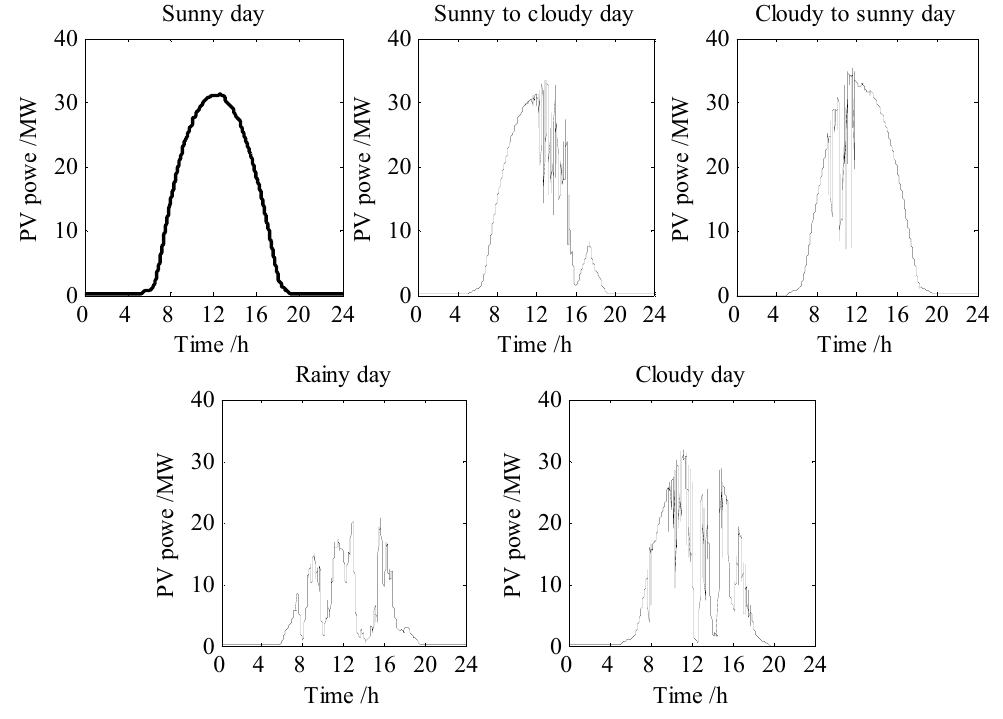
Figure 3. Typical output curves under five different types of weather.